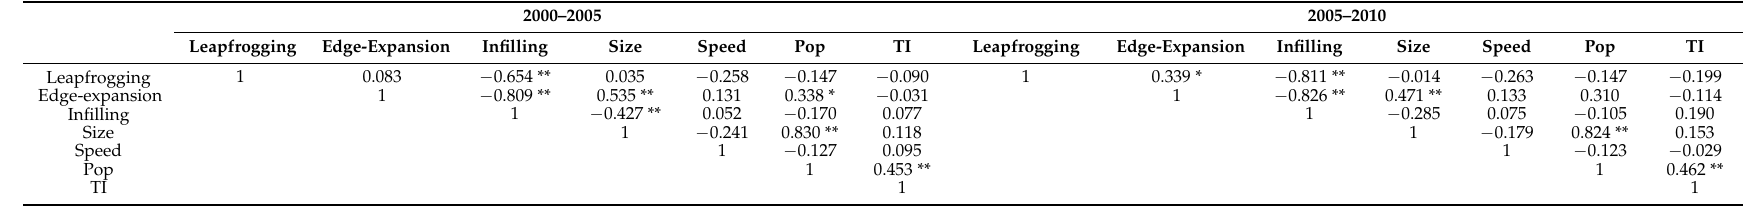
Table 2. Pearson correlation coefficients between the